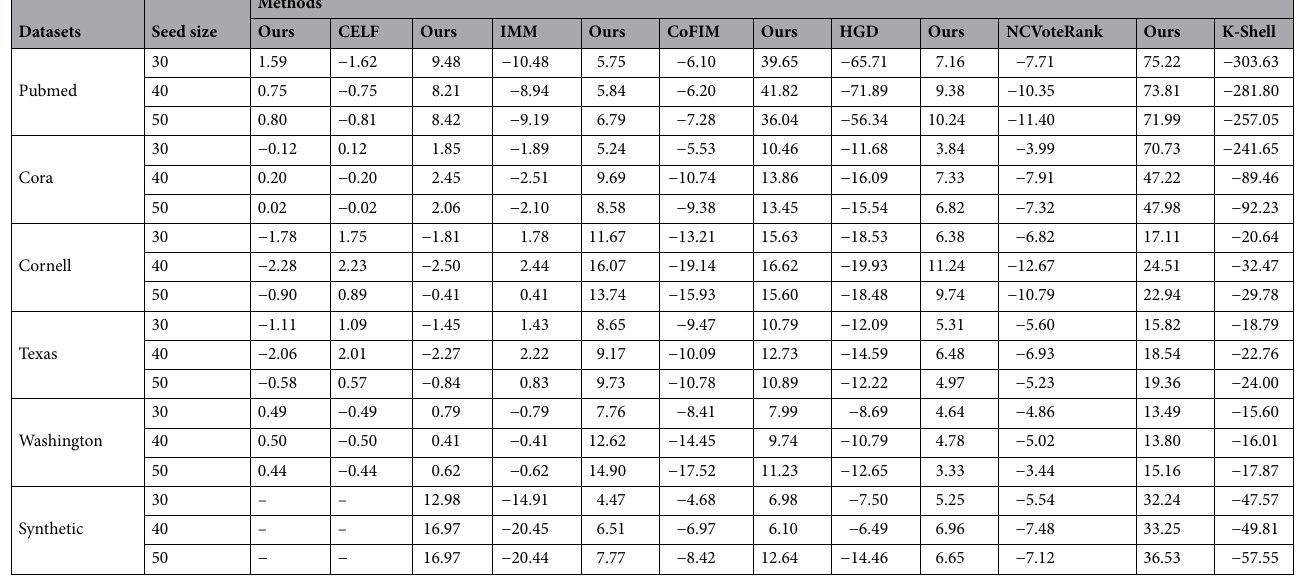
Table 3. Speedup % (in terms of influence spread) for Ours versus other baseline methods on six datasets. The propagation is simulated on the LTPlus model.